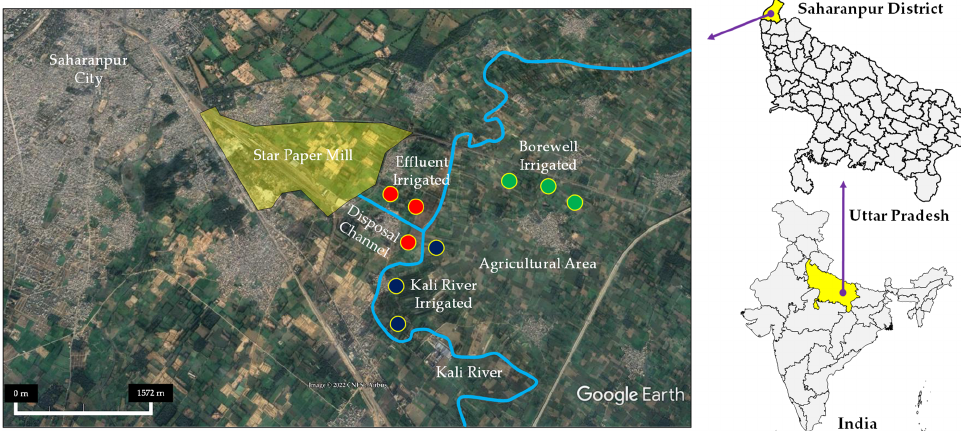
Figure 1. Map view of the Star Paper Mill situated in Saharanpur district of Uttar Pradesh, India, and its adjoining agricultural areas (Source: Google Earth Pro).